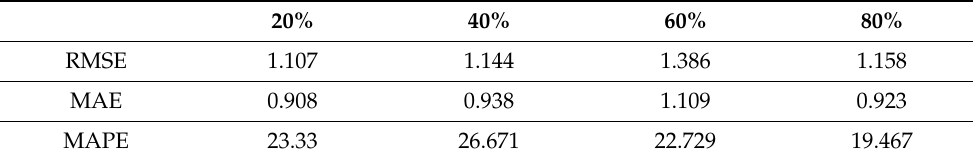
Table 10. Bilinear CNN model weight experimental result